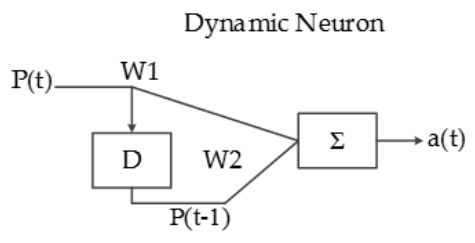
Figure 15. Implemented dynamic neuron architecture.